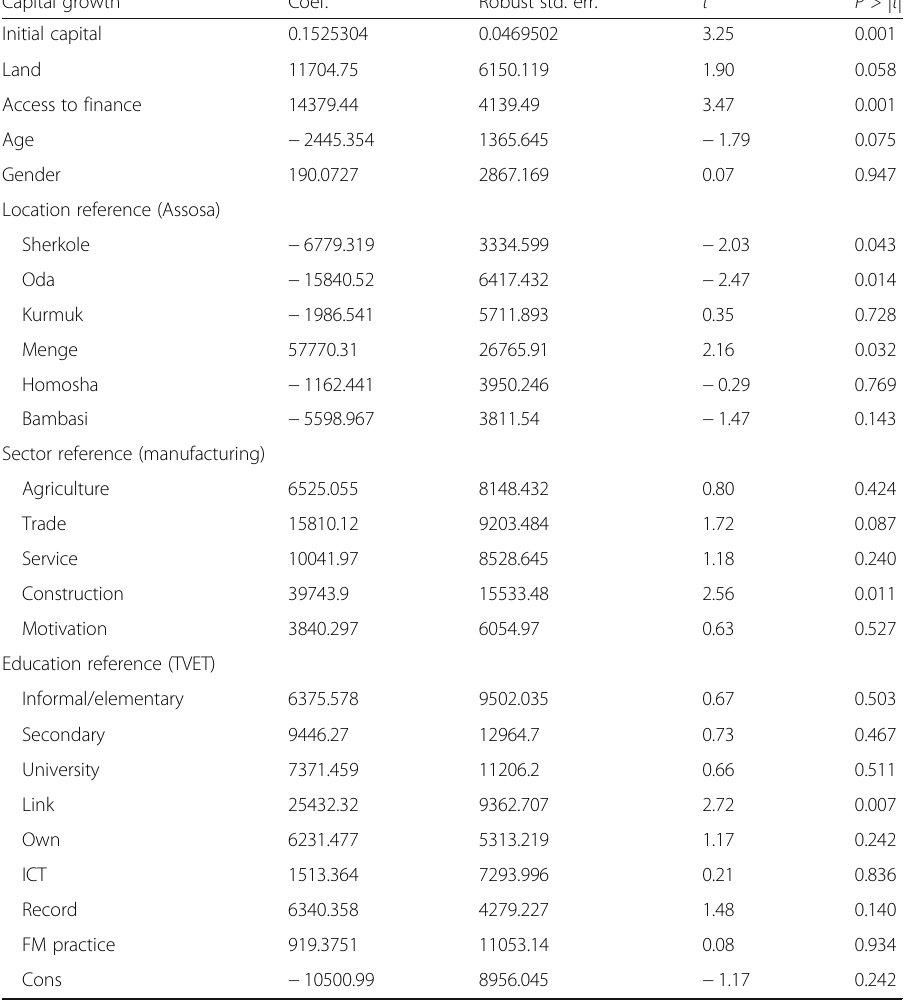
Table 5 Regression output of enterprises ’ growth determinant s Capital growth